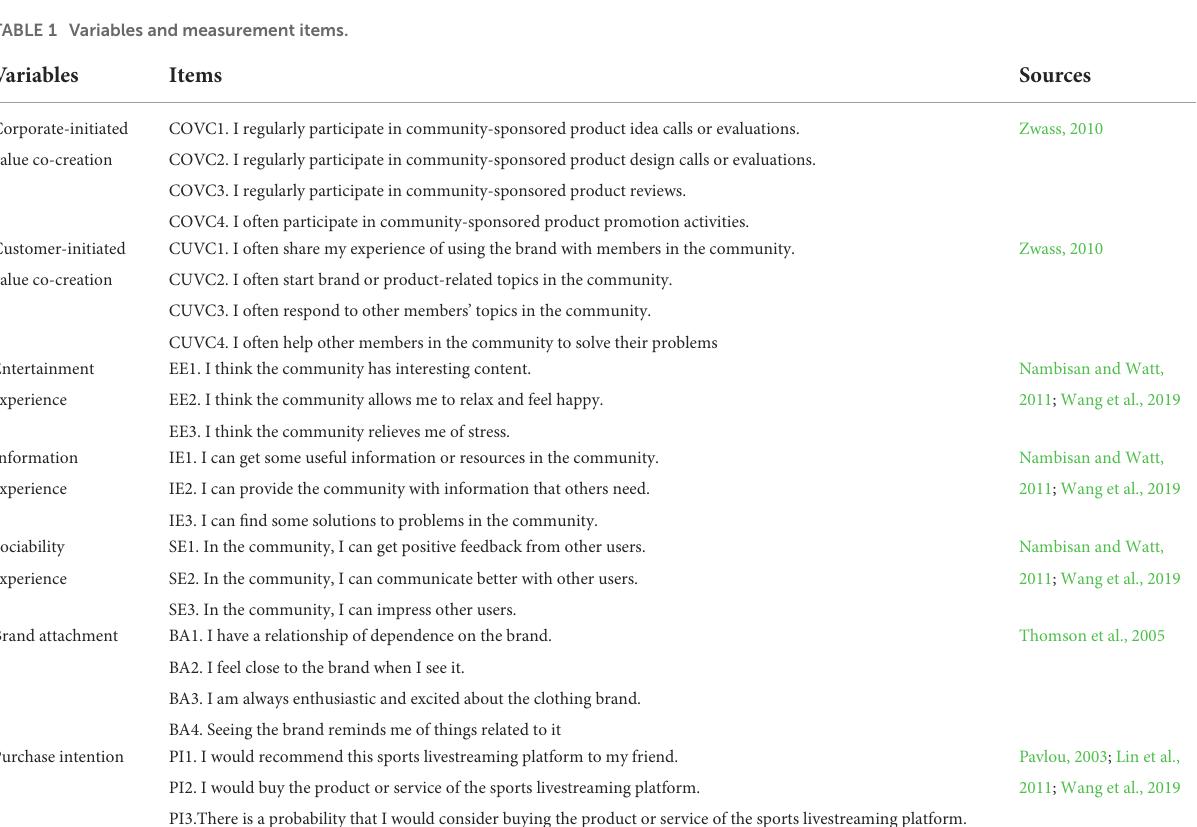
FIGURE1 Theoretical model.